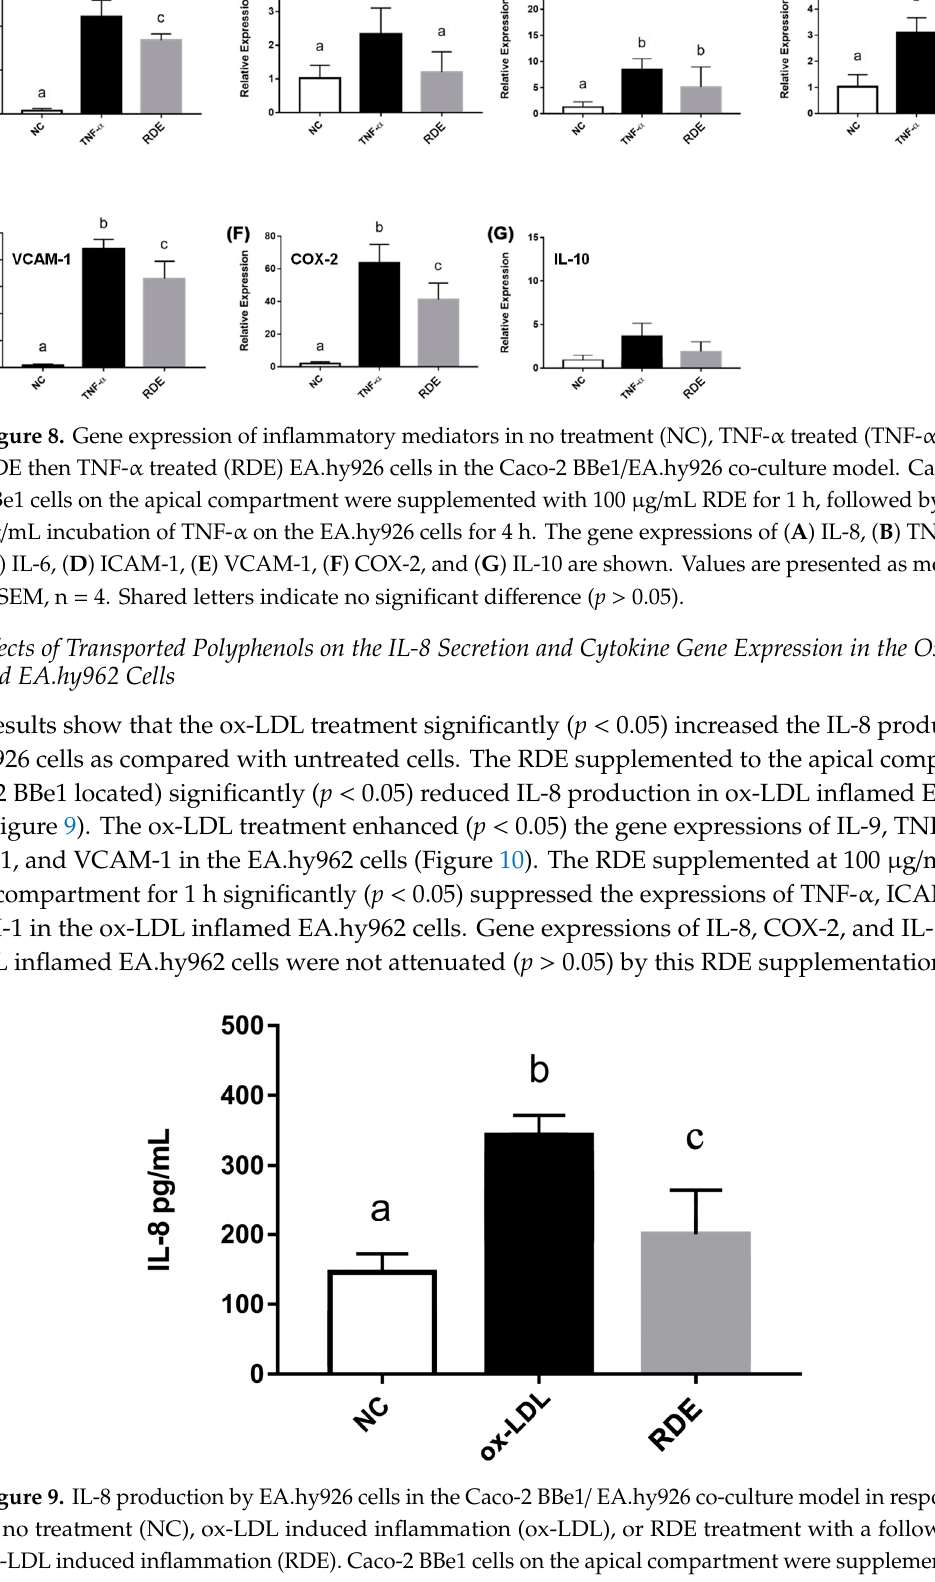
10 of 16 Figure 7. Production of IL-8 by EA.hy926 cells in the Caco-2 BBe1/ EA.hy926 co-culture model in response to no inflammation (NC), TNF- α induced inflammation (TNF- α ), or RDE pretreatment with the following TNF- α induced inflammation (RDE). Caco-2 BBe1 cells on the apical compartment were supplemented with 100 μ g/mL RDE for 1 h, followed by a 2 ng/mL incubation of TNF- α on the EA.hy926 cells for 4 h. Values are presented as means ± SEM, n = 4. Shared letters indicate no significant difference ( p > 0.05). The TNF- α treatment enhanced ( p < 0.05) the gene expressions of IL-8, TNF- α , IL-6, ICAM-1,